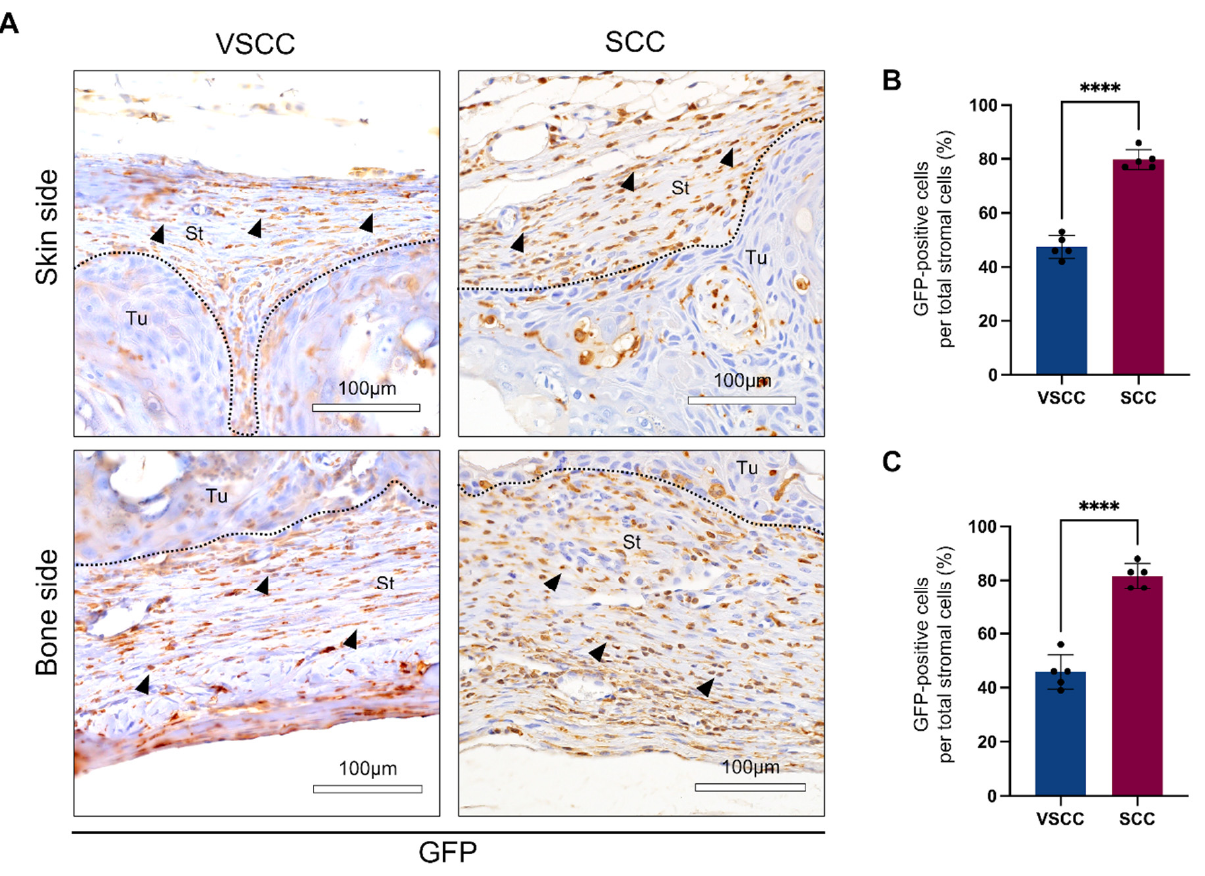
Figure 2. SCC-PDSX promotes GFP-positive BMDCs infiltration in the periphery of tumor: ( A ) Representative images of GFP IHC: upper panel: skin side; lower panel: bone side (left panel: VSCC-PDSX; right panel: SCC-PDSX); ( B ) The rate of infiltrating BMDCs into the skin side of tumors; ( C ) The rate of infiltrating BMDCs into the bone side of tumors. Dotted lines represent the boundary of the tumor (Tu) and the stroma (St). VSCC, verrucous oral squamous cells carcinoma; SCC, conventional oral squamous cell carcinoma, PDSX, patient-derived stromal cells xenograft. Statistical analyses were performed using Student’s t -test, 2-tailed; **** p < 0.0001. Dots in the plots represent the mean value of each mouse. Data are presented as the mean ± SD, n = 5.